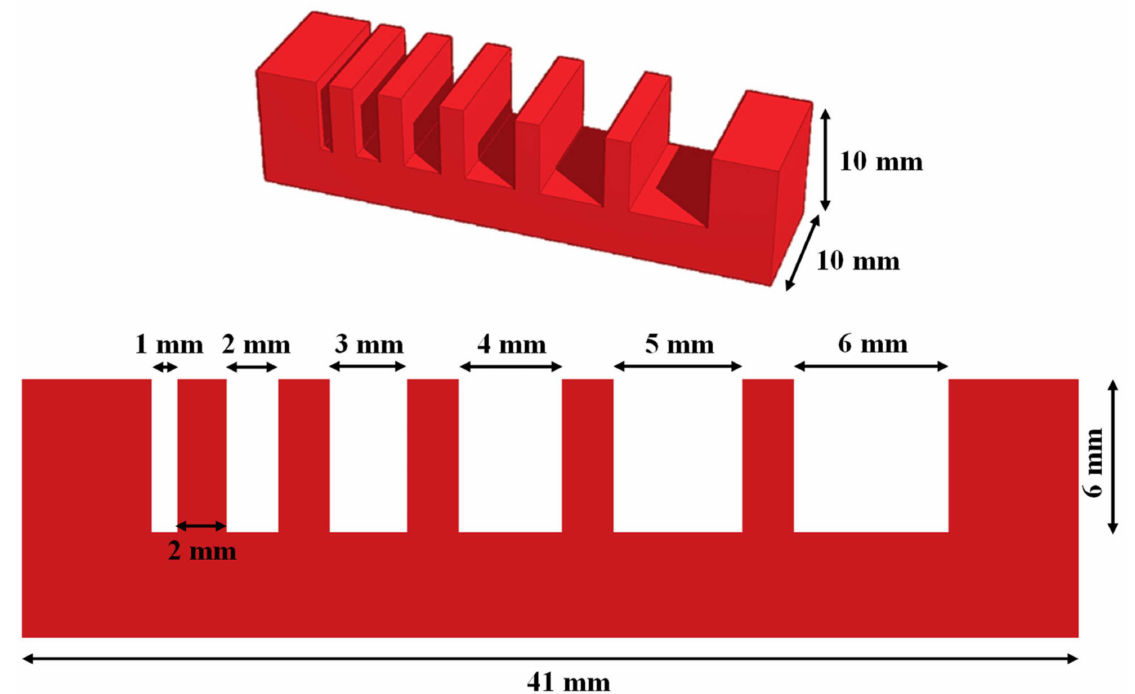
Figure 2. Model of the platform for filament collapse